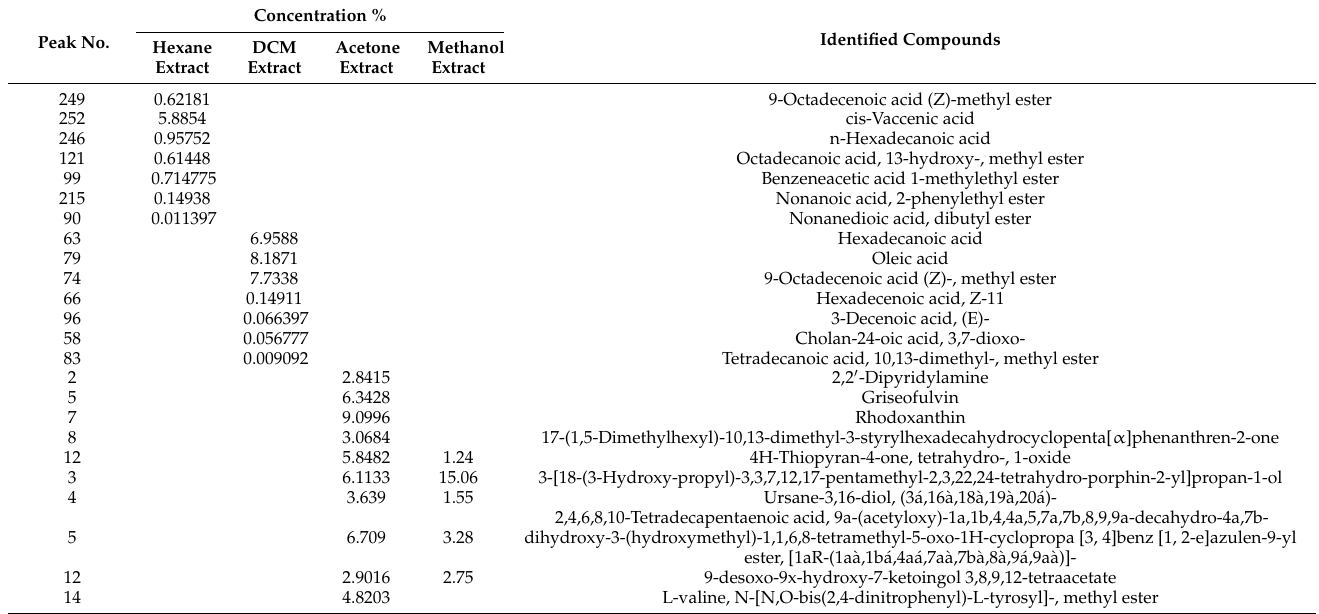
Table 2. Fatty acids and related esters present in Moringa oleifera seed oil dichloromethane and hexane extracts analyzed by